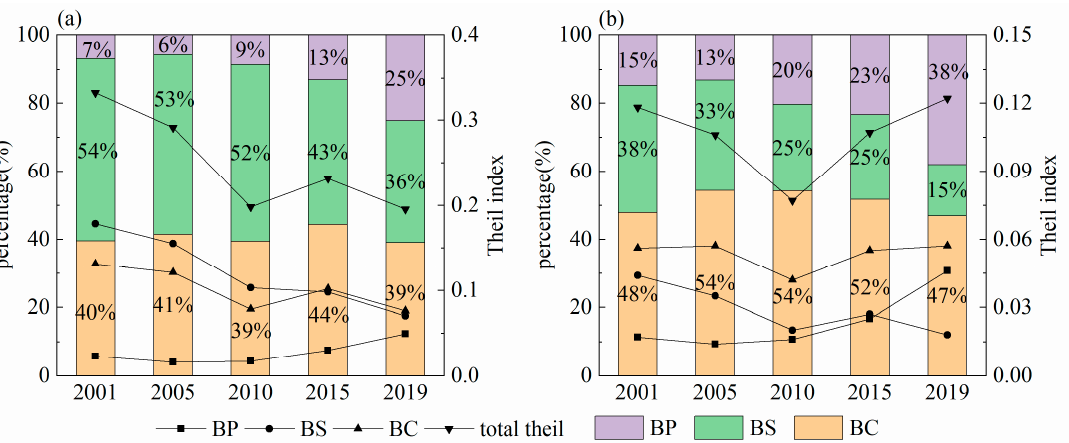
Figure 7. ( a ) Two-stage nested Theil index based on per capita CE. ( b ) Two-stage nested Theil index based on carbon intensity.